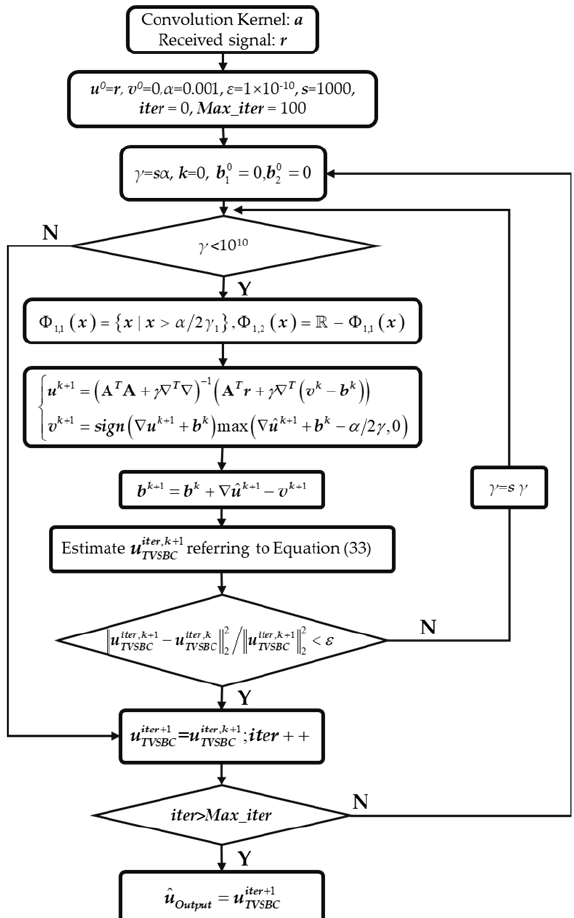
Figure 3. The flowchart of the proposed